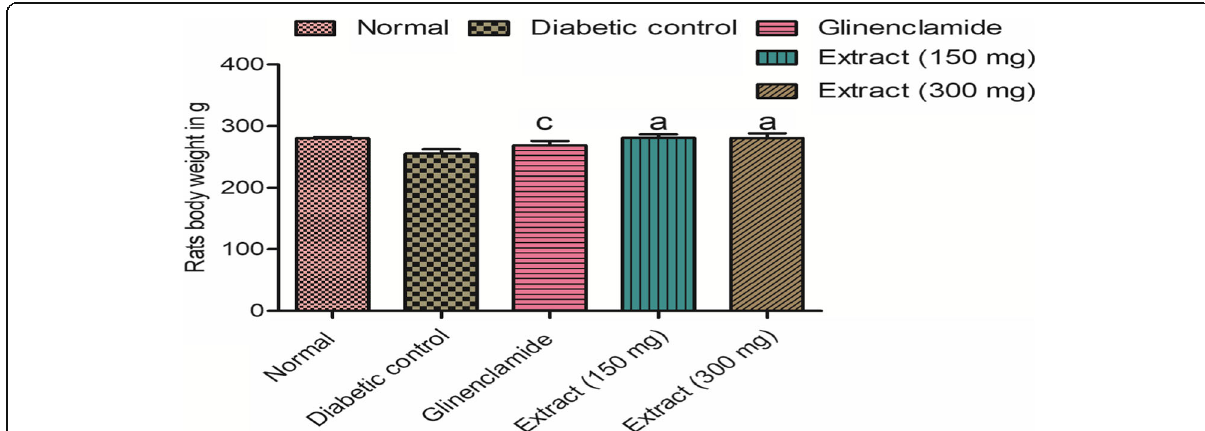
Fig. 5 Represent the effect of methanolic extract of rhizomes of Sorghum halepense (L.) Pers on body weight of diabetic rats. Represented the data ( n = 5) as Mean ± SD, a shows significance at P < 0.001 and c at P < 0.05 (Dunnett ’ s-test), the normal group was compared with the untreated group and in turn its comparison was made with extract treated group and standard